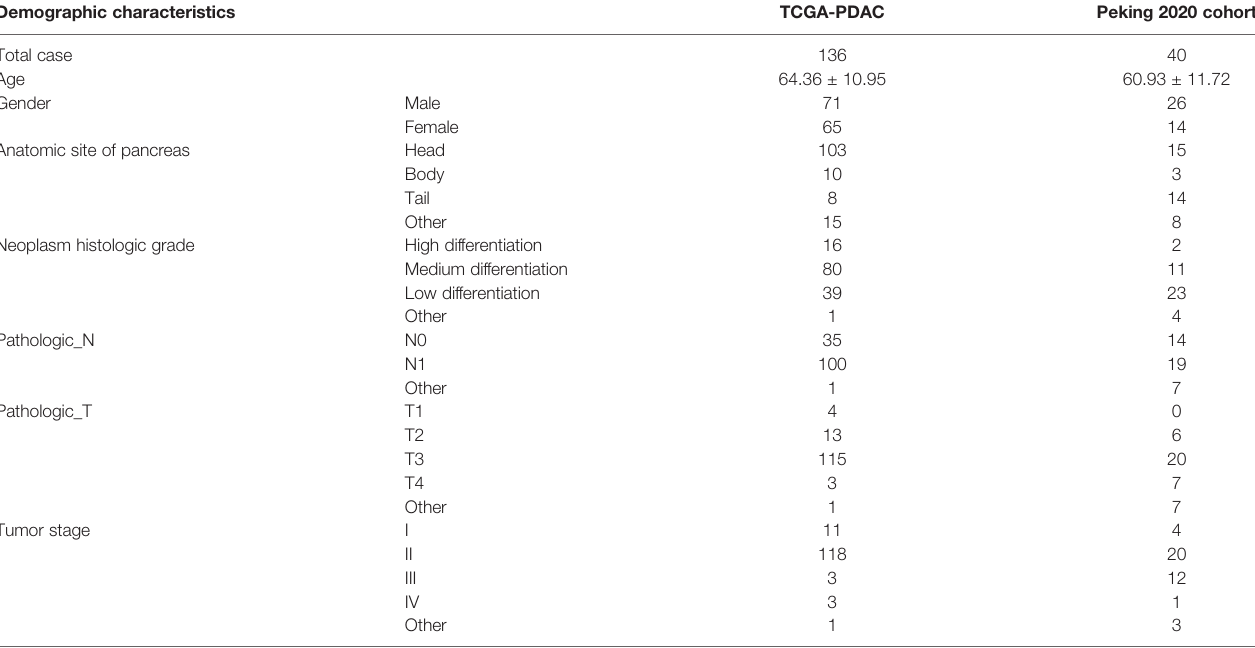
TABLE 1 | Demographic characteristics of TCGA-PDAC and Peking2020 cohort. Demographic